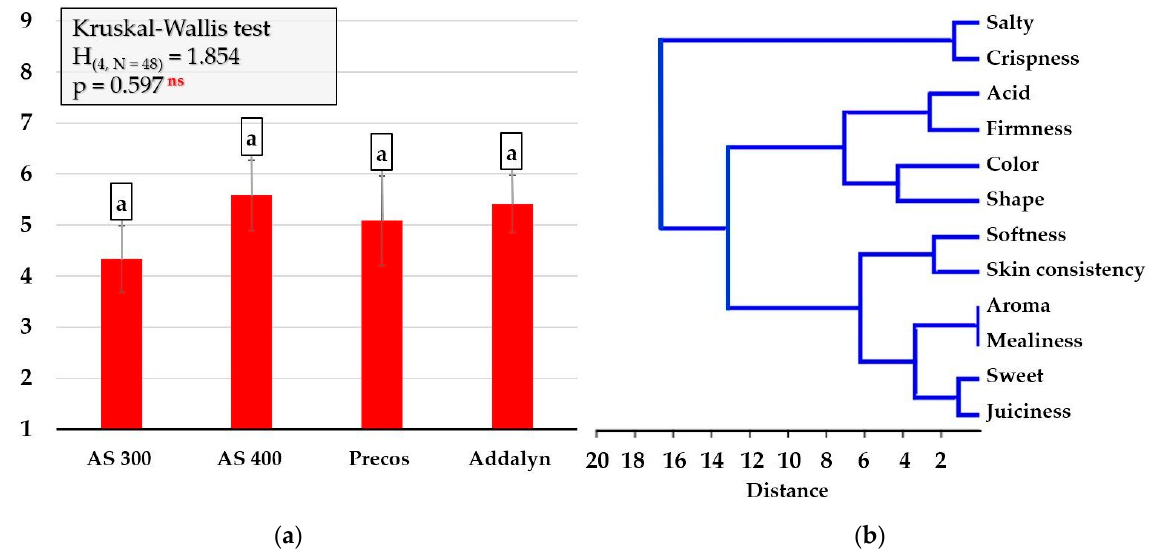
Figure 8. The final organoleptic hierarchy of tomato genotypes and the multivariate analysis of the relationship between sensory descriptors used to assess the quality of tomatoes: ( a ) mean values for the 12 organoleptic descriptors of the tomato fruits (salty, sweet, acid, color, shape, skin consistency, mealiness, softness, crispness, juiciness, firmness), following evaluations performed using a hedonic scale with grades from 1 (‘Extremely dislike’) to 9 (‘Extremely pleasant’), according to Vindras et al. [37] . Comparison of the four genotypes based on 12 sensory descriptors; means followed by the same letter do not differ by the Kruskal–Wallis test ( p < 0.05). ( b ) The hierarchical relationship (hierarchical clustering, Ward’s method) between sensory descriptors used to assess the organoleptic qualities of tomatoes in the four commercial hybrids.